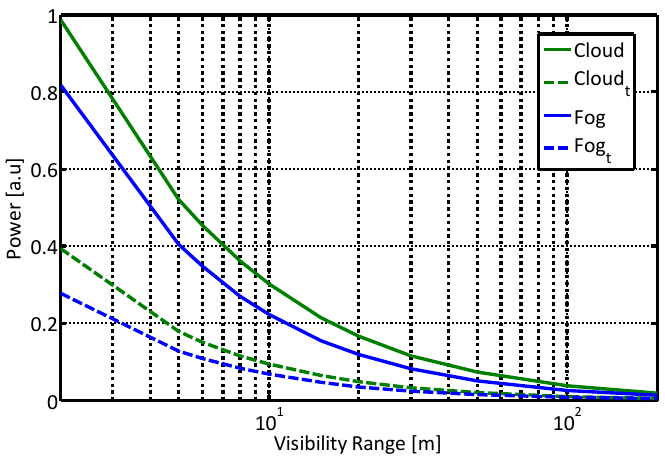
Figure 5. The calculated path-integrated single scattering power as function of visibility inside cloud-like and fog-like hydrosol clouds, for un-polarized and polarized (marked by t ) signals.